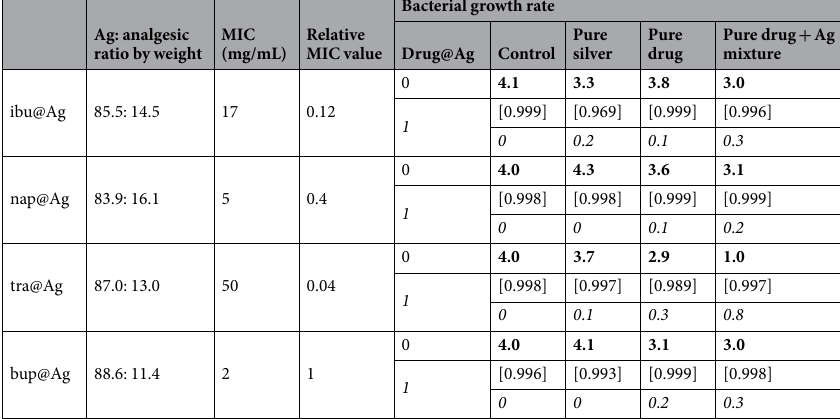
Table 5. The biocidal activity of the four composites and comparison with blanks * . * The fifth to the ninth columns read as follows: Within each box, first entry in bold - bacterial growth rate (CFU × 10 6 )/(ml × min), with an error range of approximately ± 0.1 (Fig. 5); second entry – the correlation coefficient, [R 2 ], of the straight line fits (Fig. 5); third entry – the relative efficiency of inhibition compared to the composite.